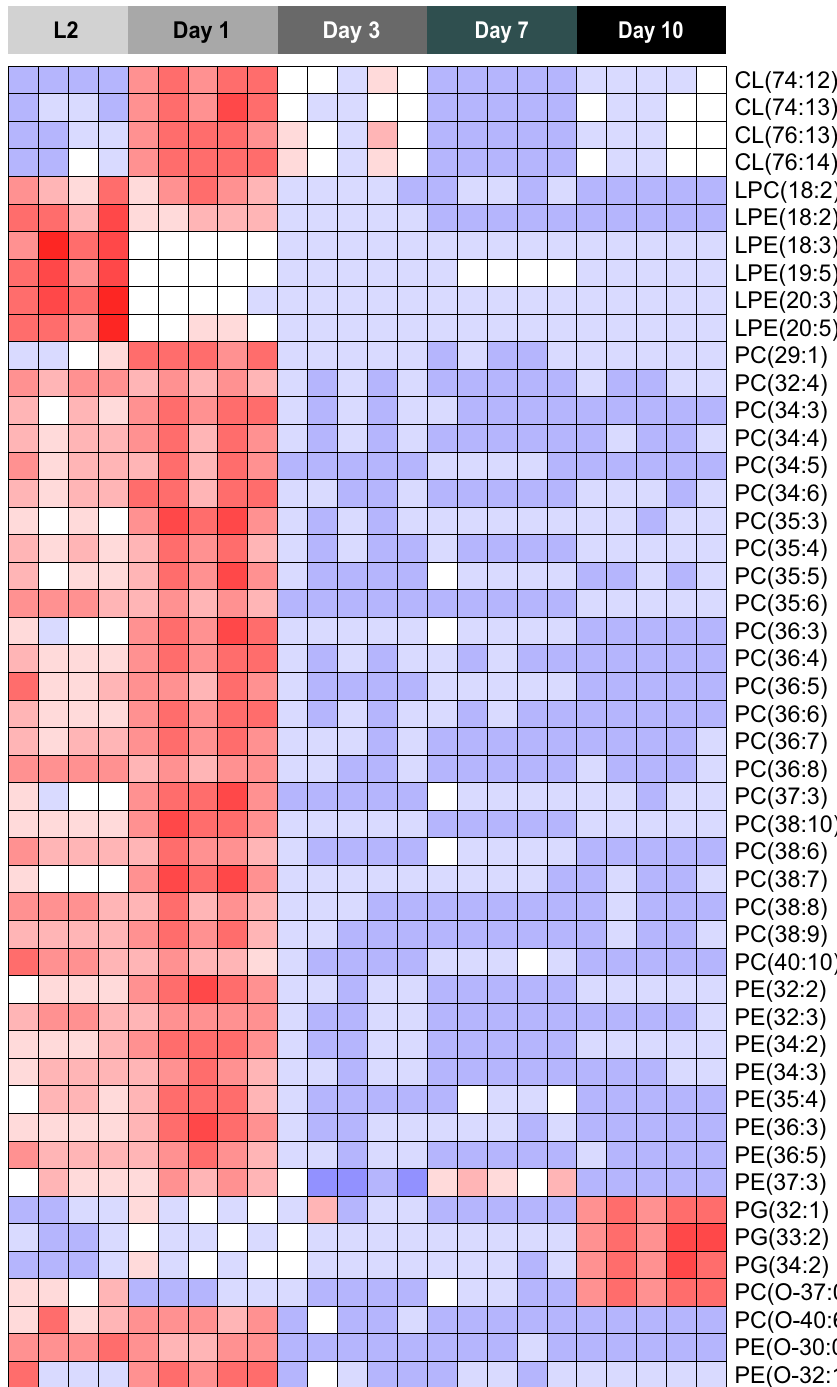
Figure 5. PL profiles during life history of C. elegans . PLs were measured in different stages of C. elegans life history. Several PL species, including many PCs, PEs, and LPEs were higher in L2 larvae and day 1 adults, and declined with age. Some CL species displayed a peak on day 1, while remaining at lower abundance during other life stages. Conversely, a few PG species had low abundance in early and mid- life stages, and displayed a marked increase in day 10 adults. See also Supplementary Table